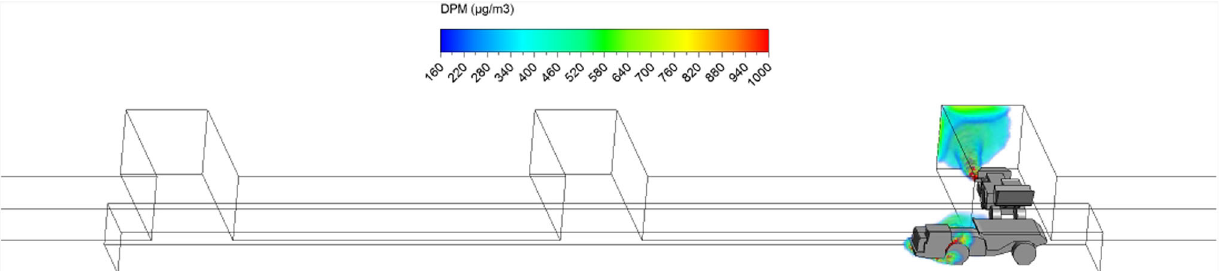
Fig. 8 DPM distributions in scenario 1 during the loading operation at 3